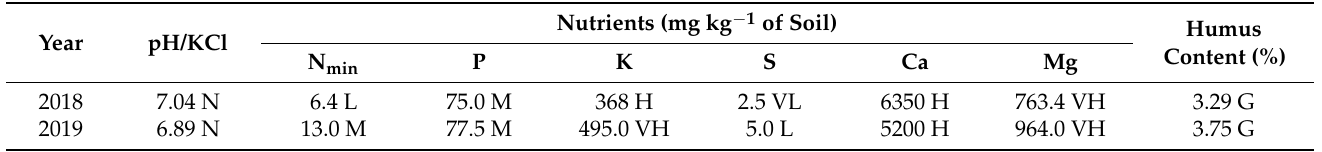
Table 2. Soil analyses before experiment establishment in 2018 and